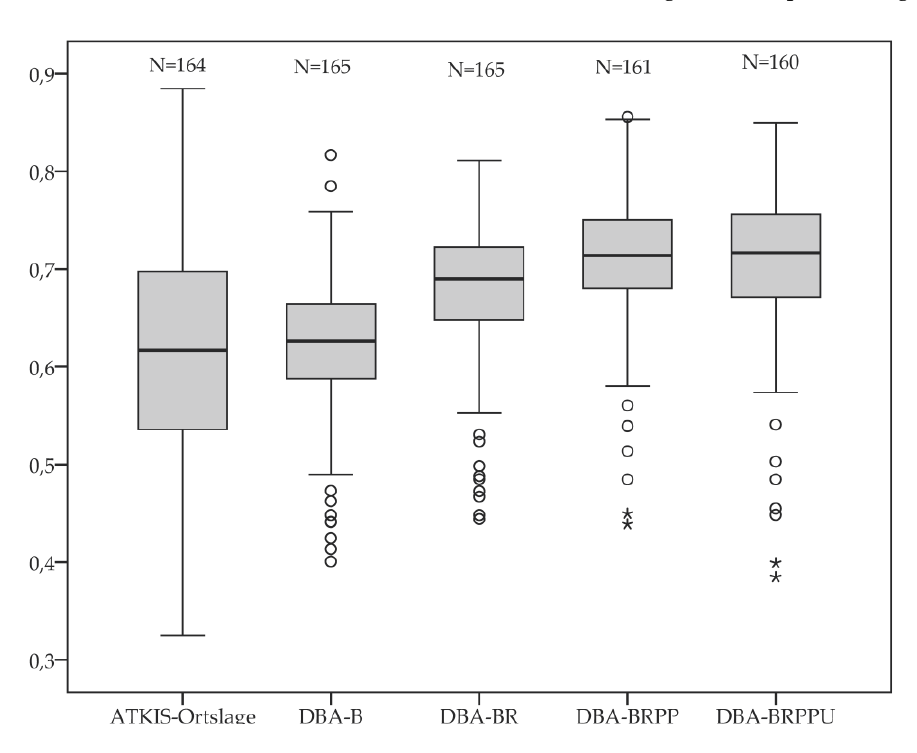
Figure 6. Boxplots of Q BOM values for single feature evaluation.